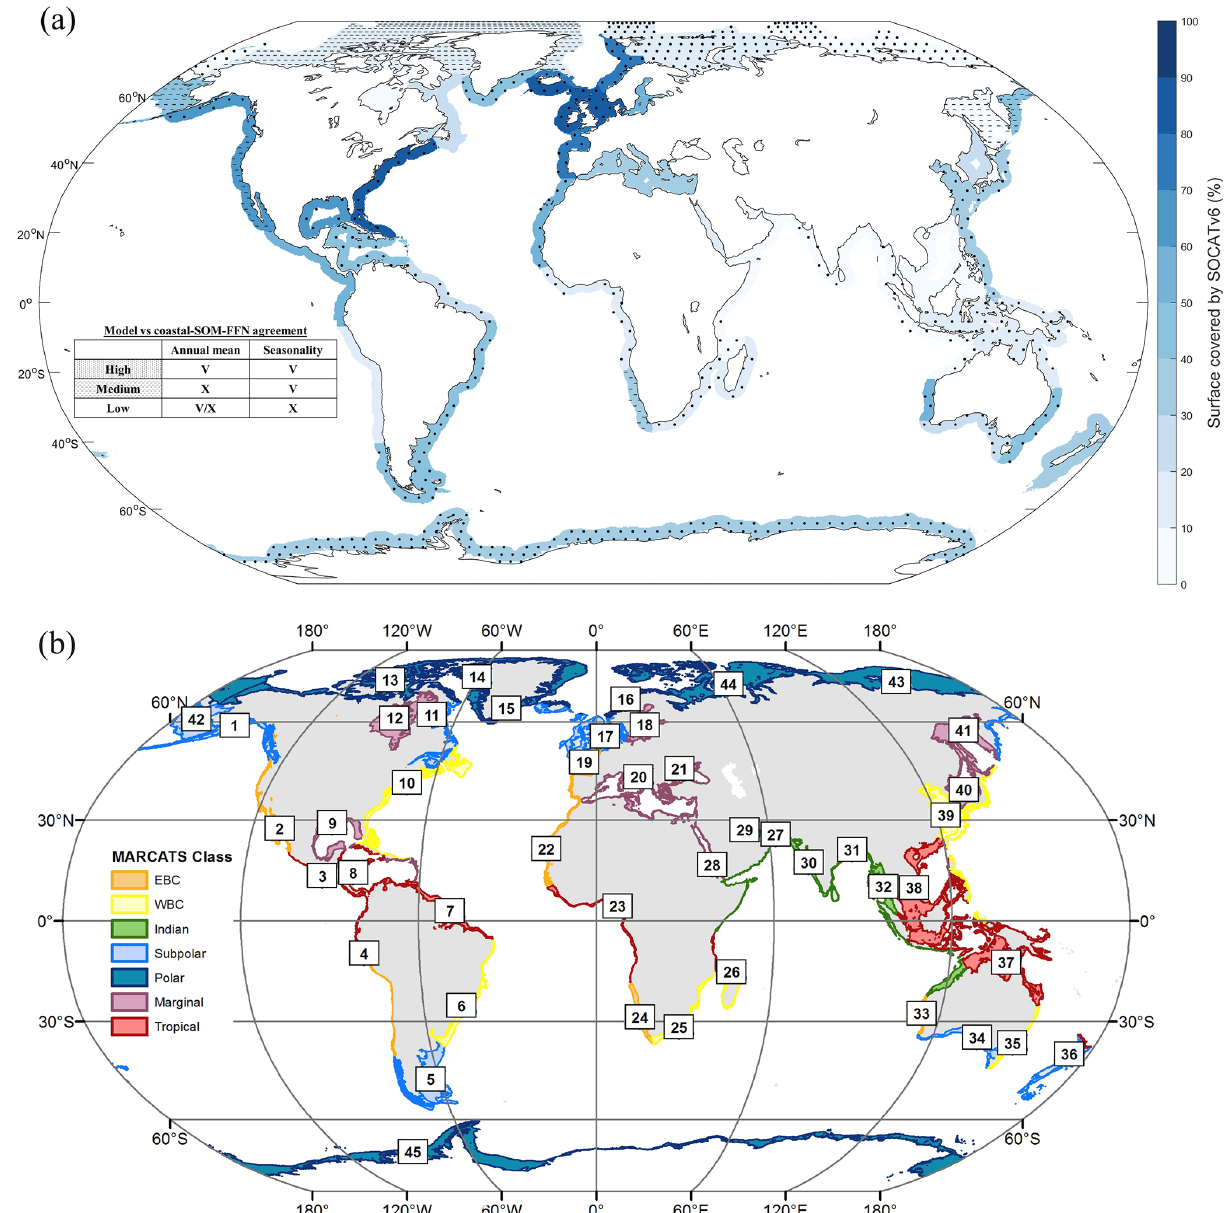
Figure 1. (a) SOCATv6 spatial coverage (color) and agreement between model and coastal SOM-FFN product (symbols) in coastal MAR- CATS (Margins and CATchment Segmentation) regions. The blue intensity indicates the fraction of the MARCATS region’s surface area covered by SOCATv6 observations (from light to dark blue). Dots indicate where the model fulfills three evaluation criteria (“high” agreement regions) of the spatiotemporal p CO 2 distribution (i.e., annual mean mismatch < 20µatm between MOM6-COBALT and coastal SOM-FFN, Pearson correlation coefficient > 0.5, and seasonal amplitude mismatch < 20µatm). Dashes indicate where the model only fulfills two cri- teria (seasonal amplitude and phase, “medium” agreement). Other regions (“low” agreement with no symbol) do not fulfill the two criteria associated with seasonality. Details of the model to coastal SOM-FFN agreement are given in Table 1. (b) Discretization of the coastal seas into 45 MARCATS regions (Laruelle et al., 2013) grouped into the following seven classes: Eastern Boundary Current (EBC, MARCATS 2, 4, 19, 22, 24 and 33) and Western Boundary Current (WBC, MARCATS 6, 10, 25, 35 and 39), polar (MARCATS 13, 14, 15, 16, 43, 44, and 45) and subpolar margins (MARCATS 1, 5, 11, 17, 34, 36 and 42), tropical margins (MARCATS 3, 7, 8, 23, 26, 37 and 38), Indian margins (MARCATS 27, 30, 31 and 32), and marginal seas (MARCATS 9, 12, 18, 20, 21, 28, 29, 40 and